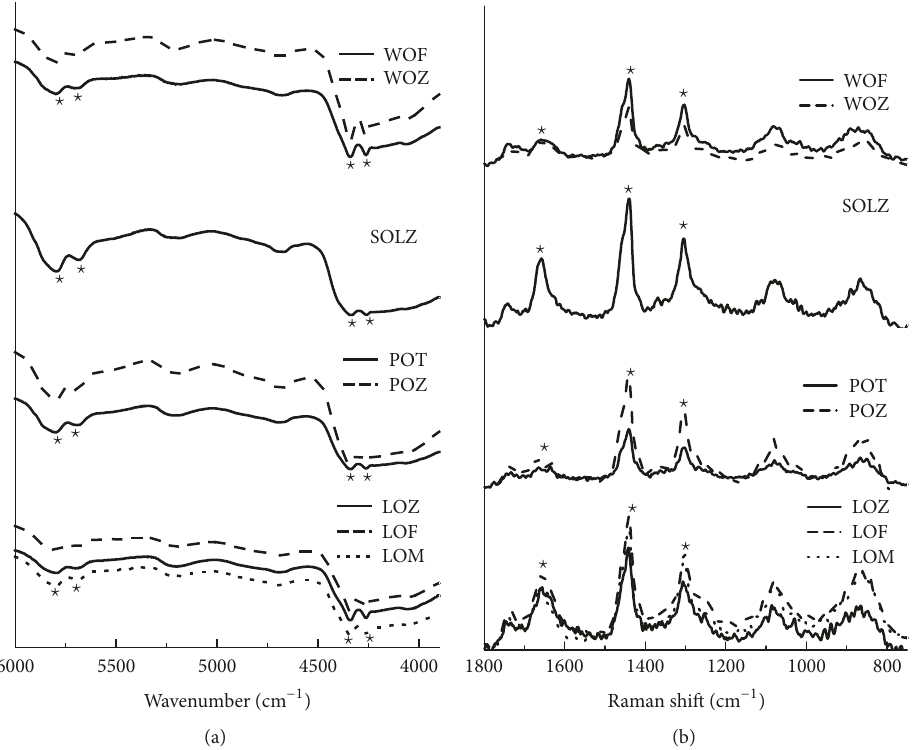
Figure 3: FT-NIR (a) and Raman (b) spectra of drying oils. Raman spectra are presented after background subtraction. Star symbols point to some specific spectral features discussed in the text. Symbols for each drying oil are taken from Table 1. The assignments of the FT-NIR and Raman spectra are reported in Tables S5 and